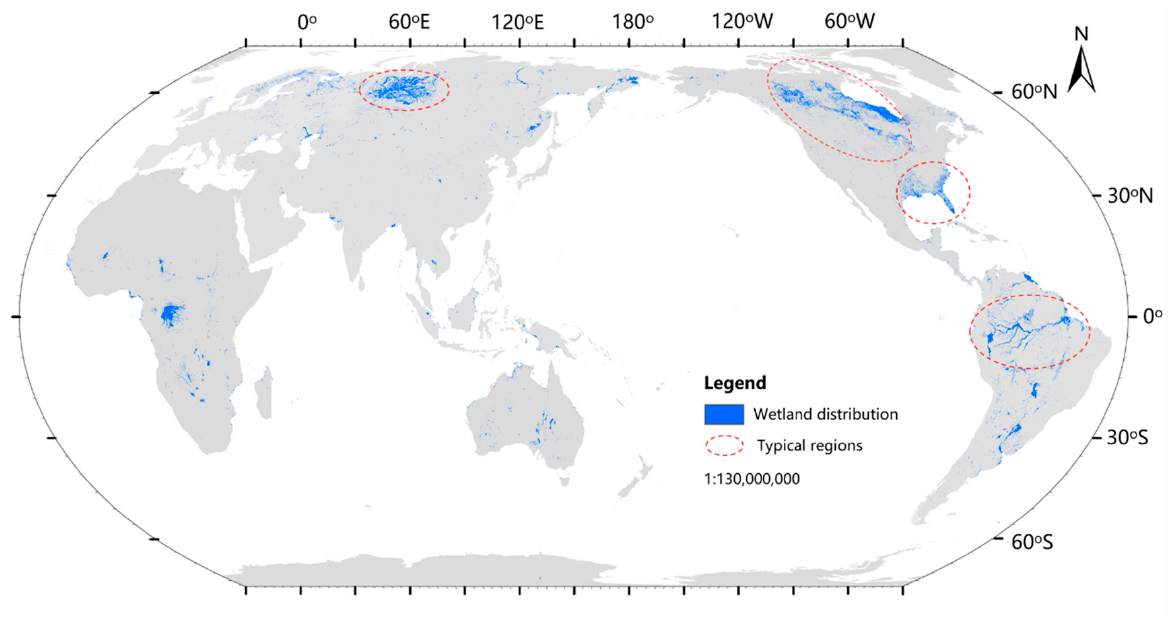
Figure 2. The spatial distribution of global wetlands in 2000.